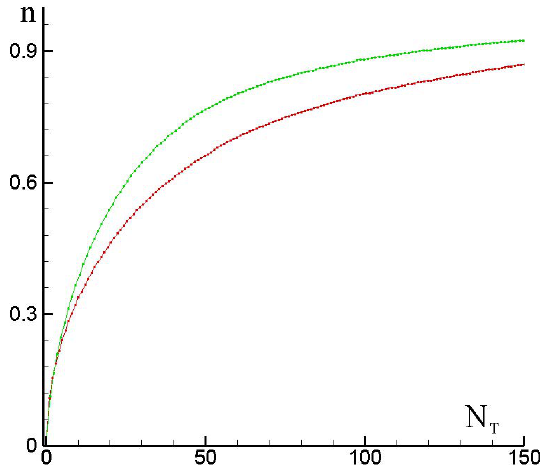
Fig. 6. Probability density as a function of the elliptic rings’ major semiaxis a in the perturbed state case. The curves depict the prob- ability density at the instants corresponding to different number of the vortex rotation periods. Vertical dashed line marks the vortex’s boundary.